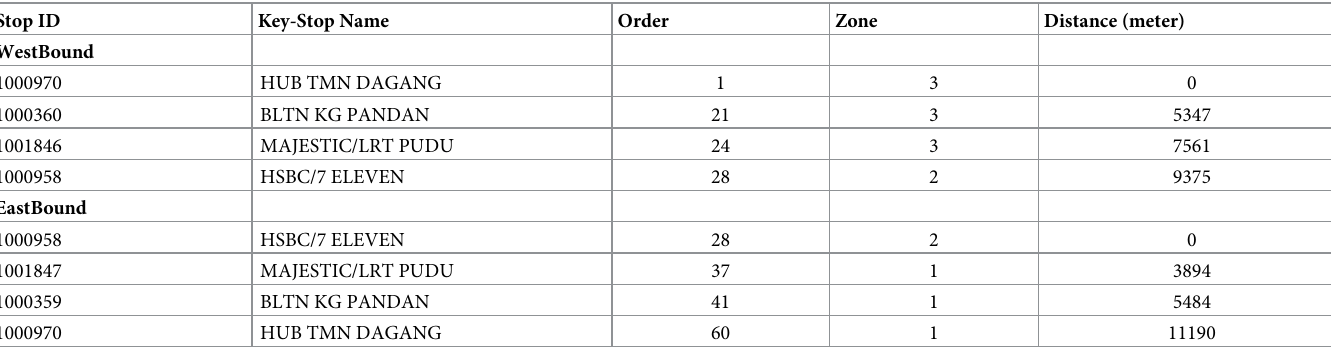
Table 2. Route U32 key stops.